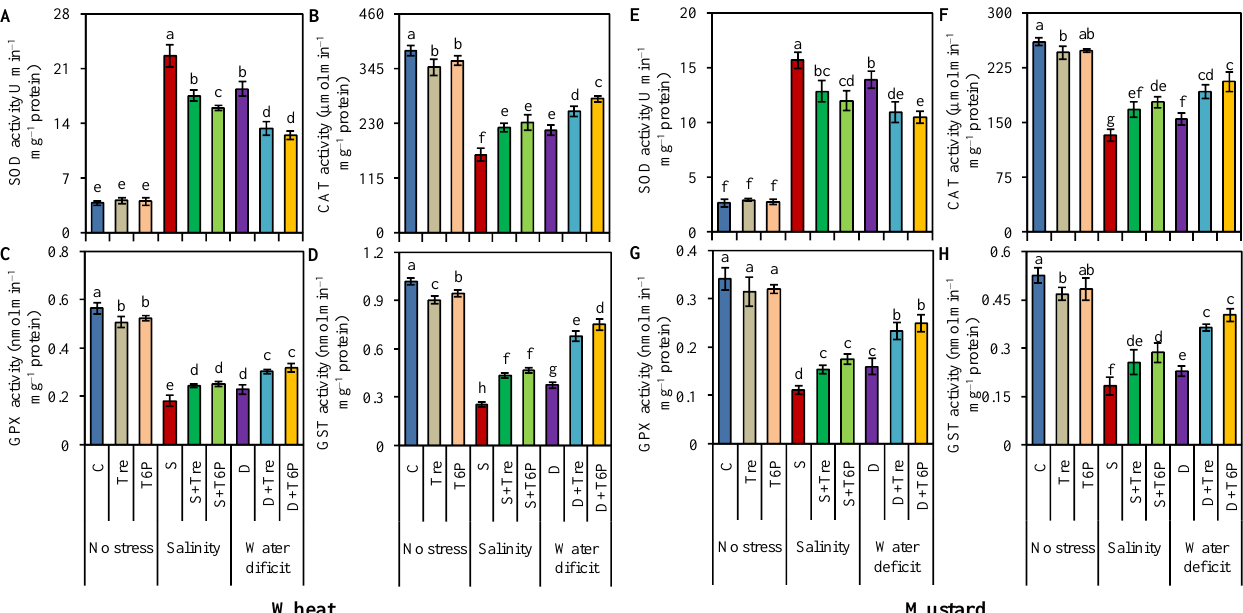
Figure 5. Effect of trehalose and T6P on the activities of SOD, CAT, GPX, and GST in wheat and mustard seedlings. Wheat seedlings were grown in a hydroponic solution containing 300 mM NaCl for 9 days. Mustard seedlings were grown in 200 mM NaCl for 10 days. For water deficit treatment, wheat seedlings were treated with 20% PEG, while mustard was treated with 12% PEG for four days. C, control; ( A – D ) wheat; ( E – H ) mustard; Tre, 200 µM trehalose; T6P, 200 µM trehalose 6-phosphate; S, NaCl treatment; D, water deficit treatment with PEG 6000. Means were calculated from three replicates for each treatment, and the bars represent the standard deviation (±SD). Values with different letters are significantly different at p ≤ 0.05 by Fisher’s LSD test. In wheat seedlings, ascorbate peroxidase (APX) activity increased (by 152 and 72%, respectively) and the activities of monodehydroascorbate reductase (MDHAR, by 66 and 55%, respectively), dehydroascorbate reductase (DHAR, by 73 and 61%, respectively), and glutathione reductase (GR, by 72 and 66%, respectively) were reduced in response to salt and water deficit stresses compared to the control. Seedlings pretreated with Tre and T6P had reduced APX activity and increased activities of MDHAR, DHAR, and GR under salt and water deficit stresses compared to the stressed seedlings only (Figure 6A – D). In mus- tard seedlings, APX (by 245 and 186%, respectively) and GR (by 6 and 14%, respectively) activities increased, but the activities of MDHAR (by 63 and 52%, respectively) and DHAR